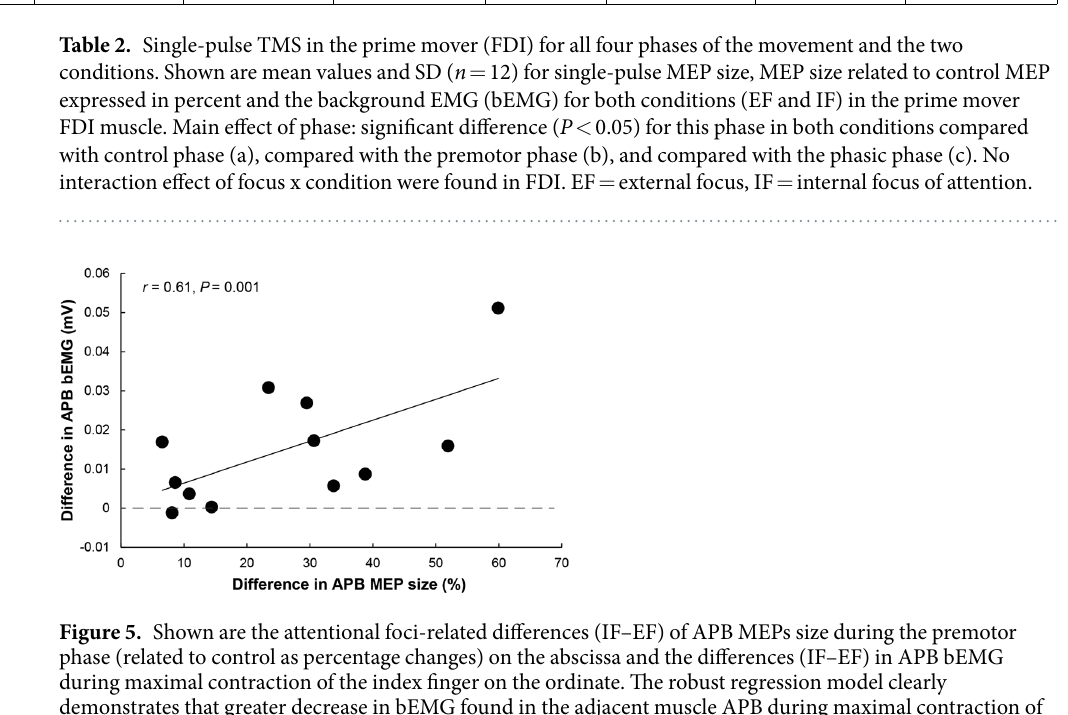
activity ( − 22.3%), MNF and MDF in the adjacent APB muscle with an EF 30 . Furthermore, despite no significant